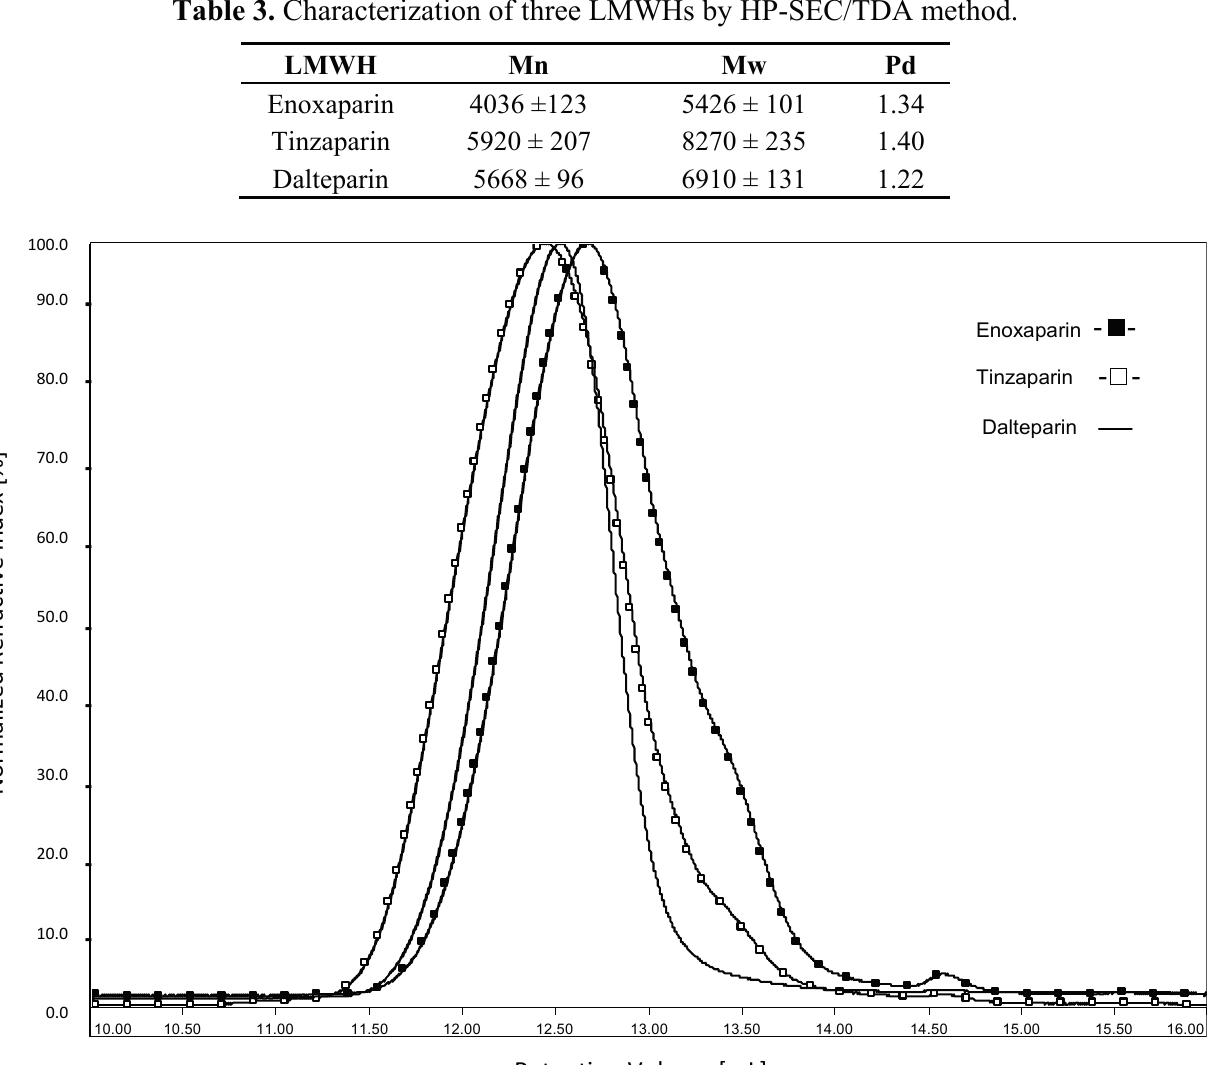
Figure 3. HP-SEC/TDA chromatograms (RI response vs. retention volume) of enoxaparin, tinzaparin and